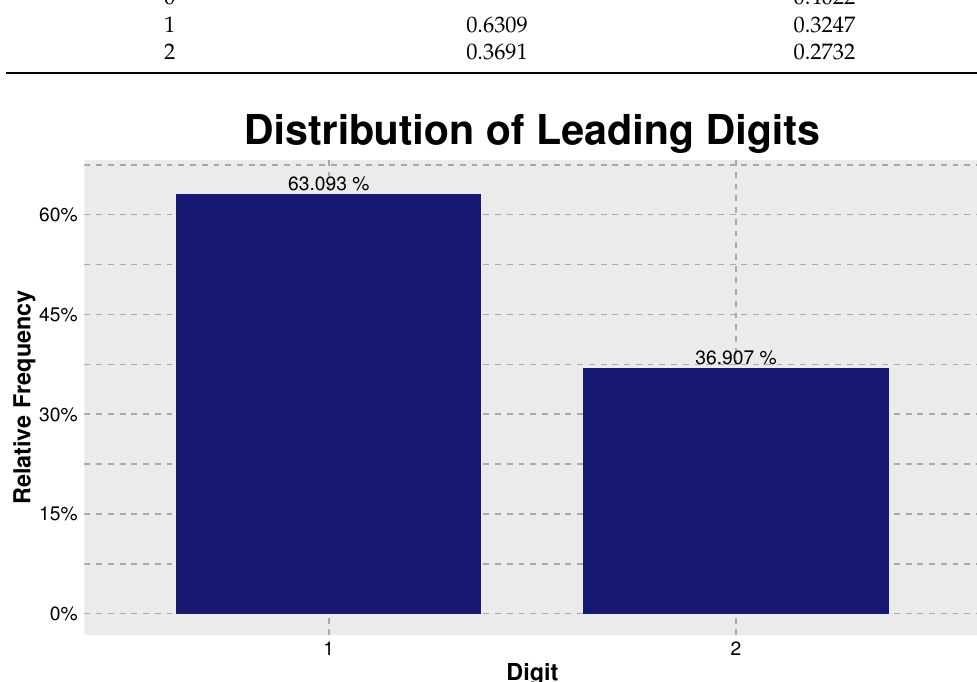
Figure 3. The distribution of the leading digit base 3 according to Benford’s